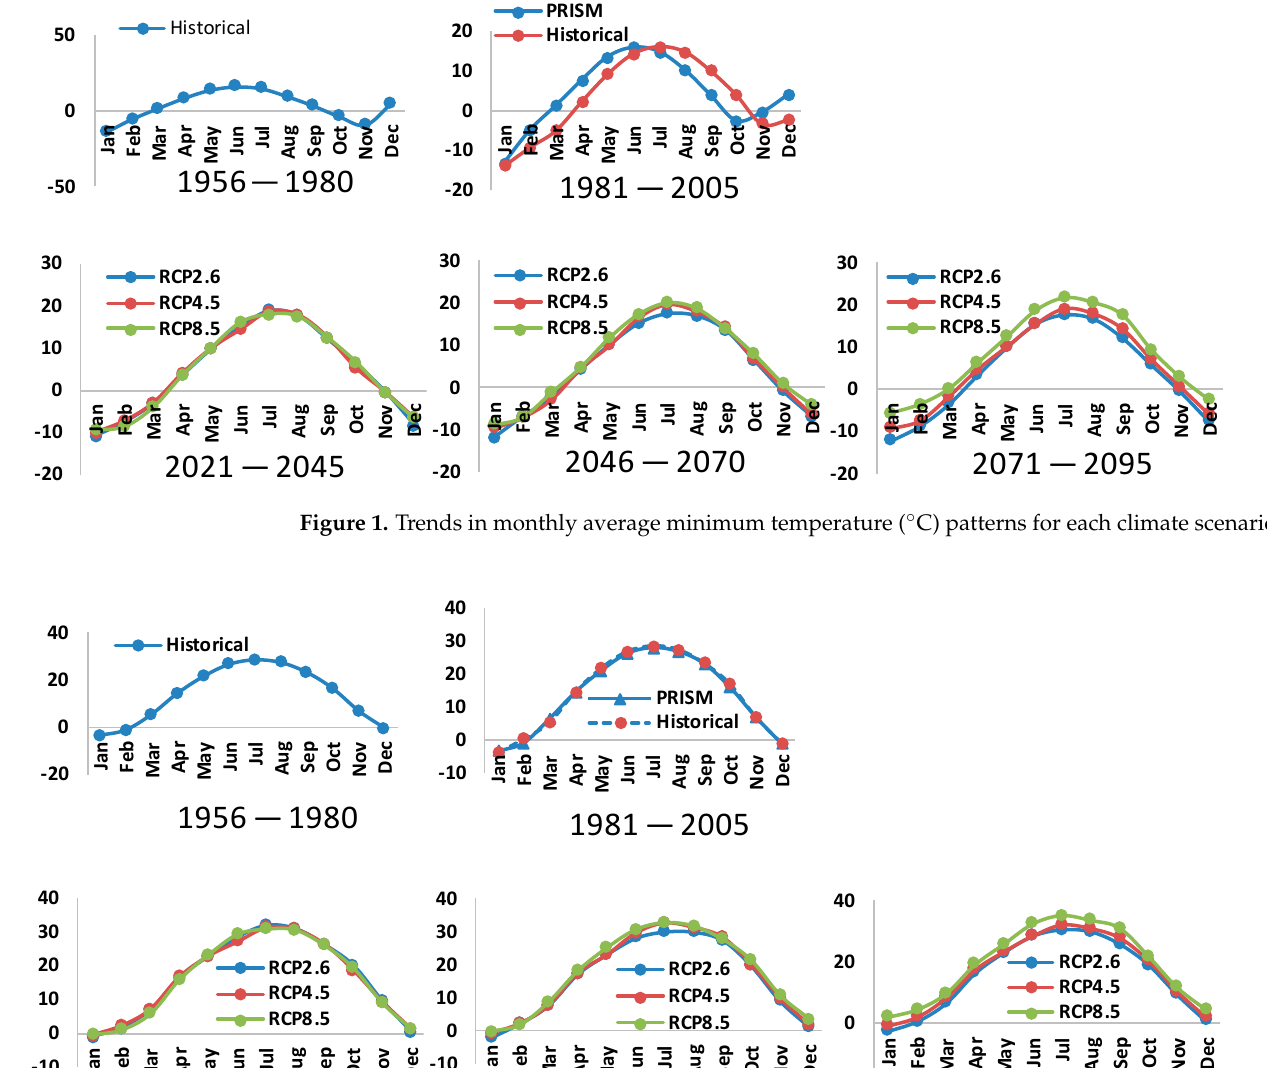
Table 4. Average annual precipitation by climate scenario (mm/year).